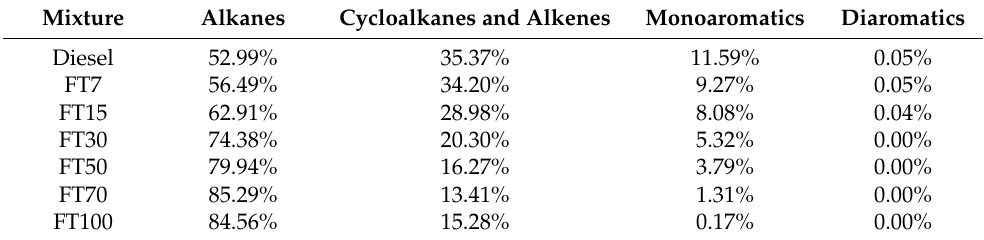
Table 5. Measured chemical composition of FT-diesel mixtures by GC × GC-TOFMS. Mixture Alkanes Cycloalkanes and Alkenes